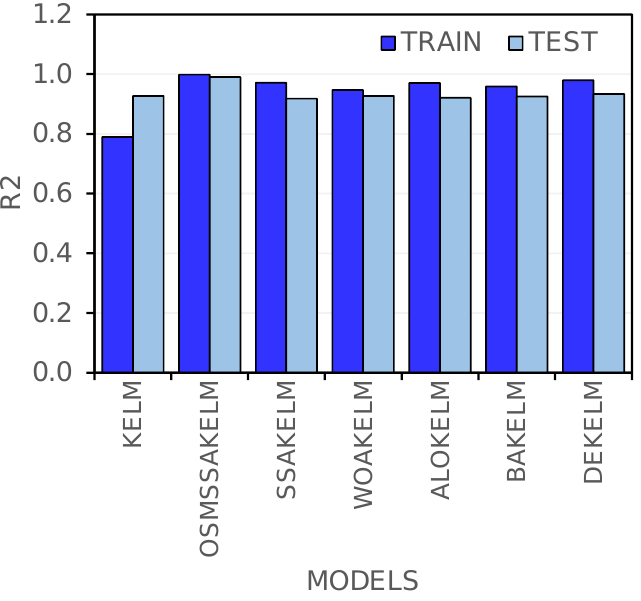
Figure 11. The histograms of the R 2 index for the testing and training stages. Figure 12 shows the scatter data on the observed PM2.5 data against the predicted PM2.5 data for the training and testing stages. These plots give a visual analysis of the predicted PM2.5 scores and prediction errors. The plots verify the higher correlation and strong relationship between the data pairs. As we can observe, the scatter plot for the OSMSSAKELM verifies the better regression performance compared to other combinations of KELM models. We can see that for most methods, the proportion of the error was located among ±40%, while the proposed method was inside the range of ±20%. From Figure 12, it is observed that the OSMSSA can enhance the correlation coefficient for training and testing data to R = 0.9991 and R = 0.9950, respectively. These results also verify that the OSMSSAKELM is the best combination for further experiments.